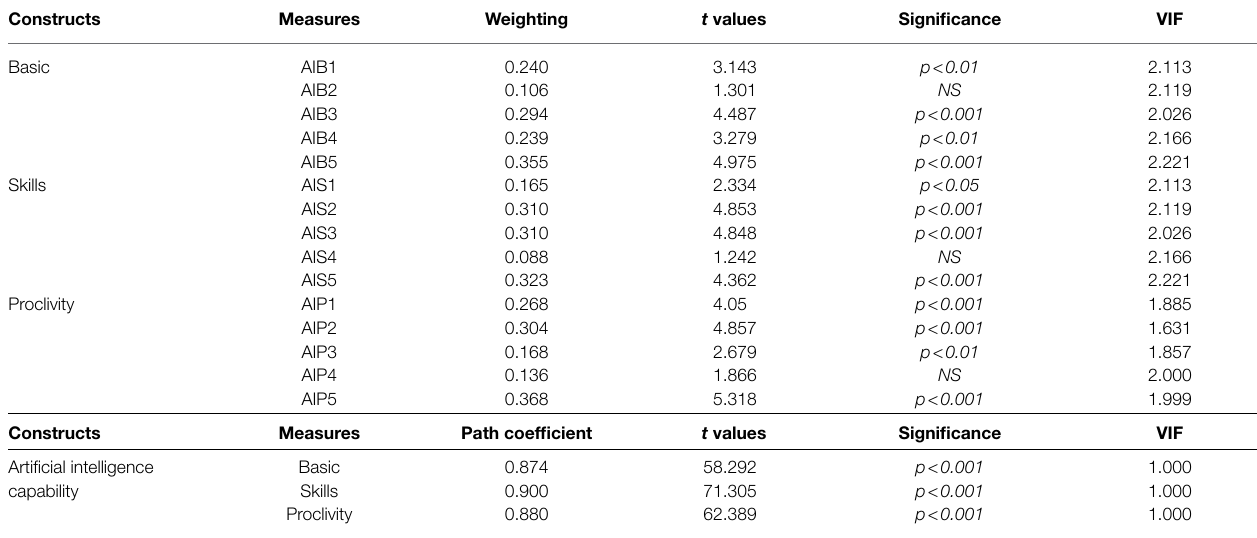
TABLE 7 | Formative constructs